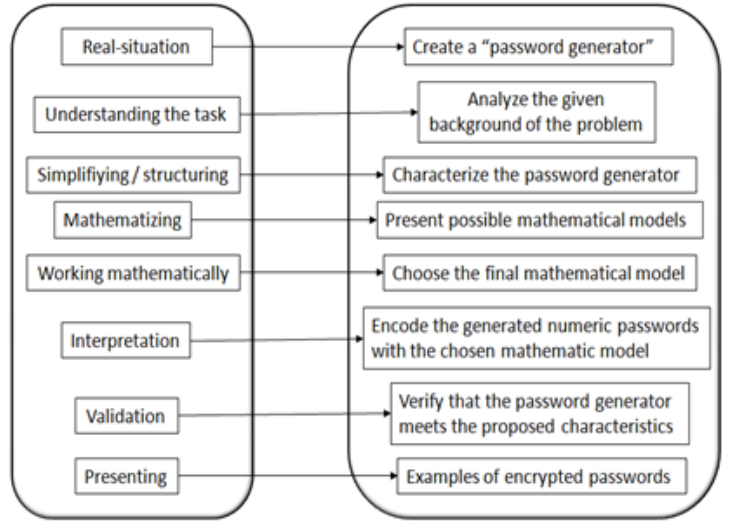
Figure 1. Mathematical modelling process followed by the students to solve the